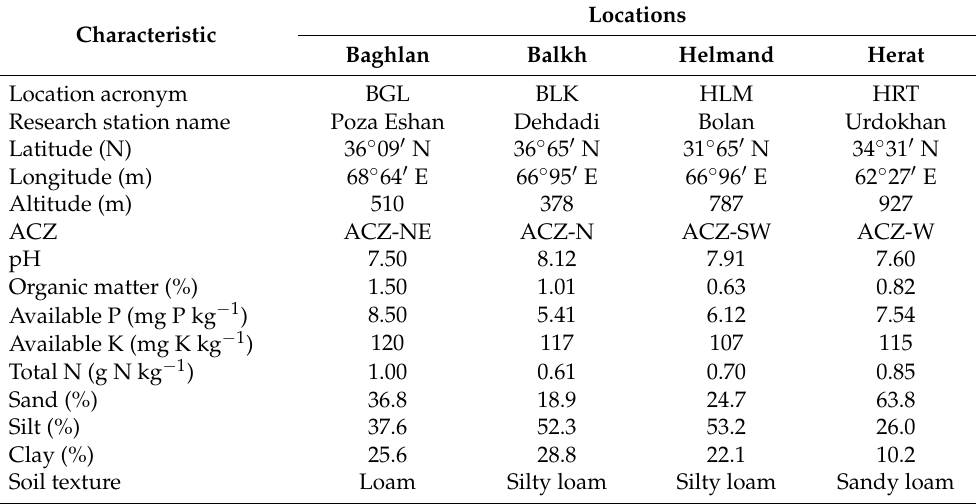
Table 1. Site and soil parameters of the experimental fields in four locations in Afghanistan. Characteristic